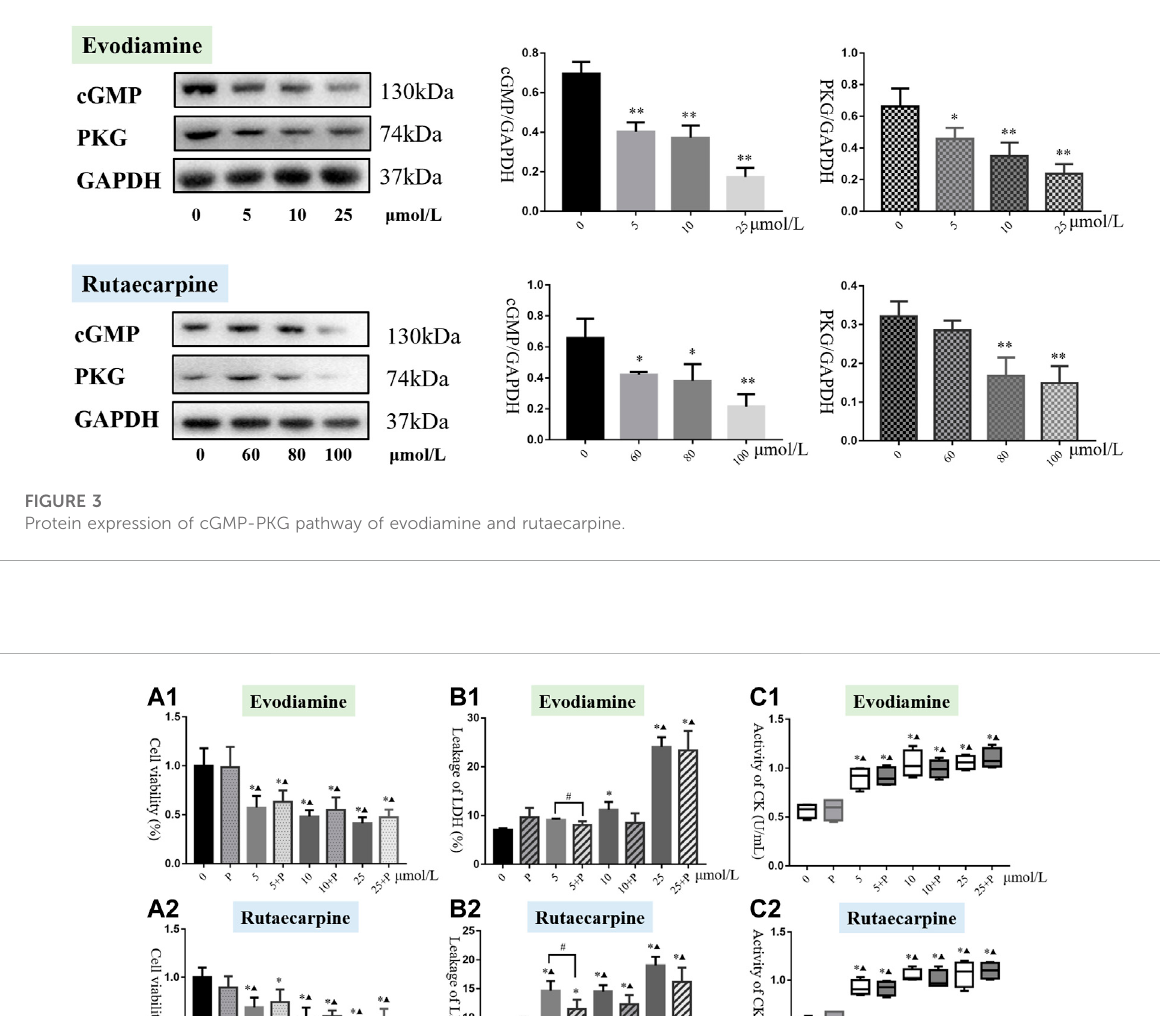
FIGURE 4 Results ofcardiotoxicity induced byevodiamine and rutaecarpine plus PKG drug G1 inH9c2 cells. Note: (A) cell viability; (B) leakage ofLDH; (C) activity of CK; (D) the protein expression of cGMP and PKG.